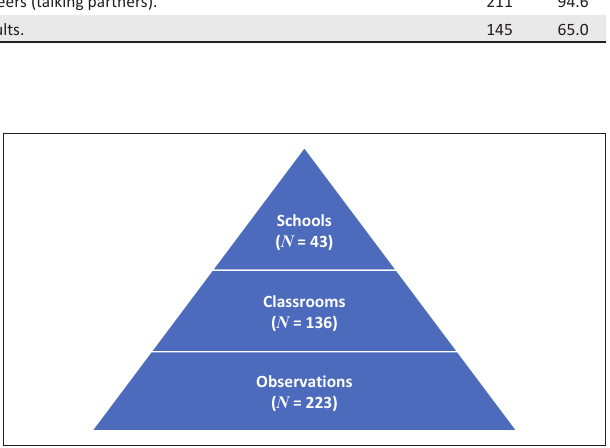
FIGURE 1: Number of schools, classroom and observations included.